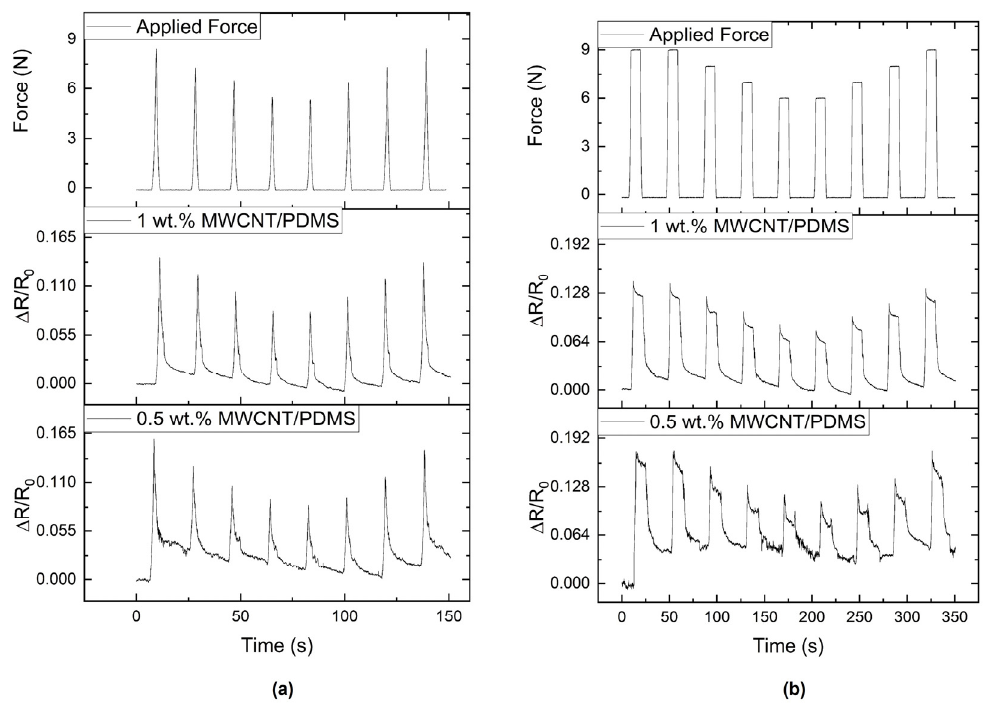
Figure 13. Piezoresistive effect for the sample with the parallel lines pattern with 0.5 and 1 wt.% of MWCNT/PDMS. ( a ) unloading-loading peaks, ( b ) unloading-loading delayed peaks.